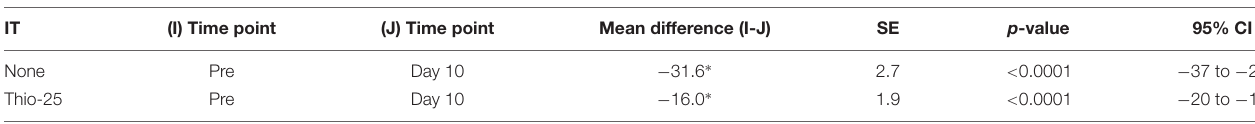
TABLE 2C | Pairwise comparisons of the analysis results presented in Table 2A